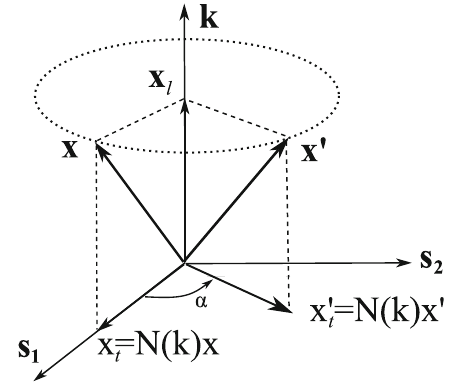
Fig. 1 The rotation matrix R ij can be parameterized by the unit vector k and the angle α < π